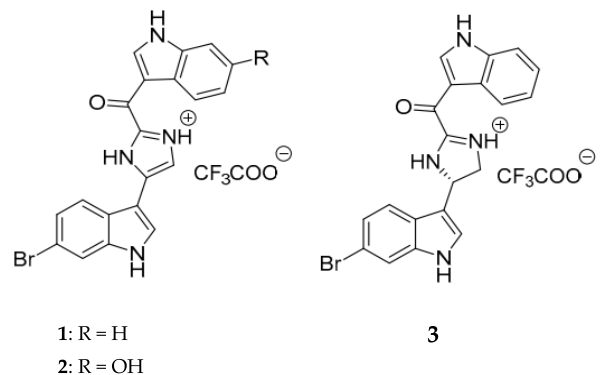
Figure 1. Structures of the three bis-indole alkaloids investigated herein: 6-bromodeoxytopsentin ( 1 ), 6-bromotopsentin ( 2 ), ( − )-spongotine A ( 3 ).